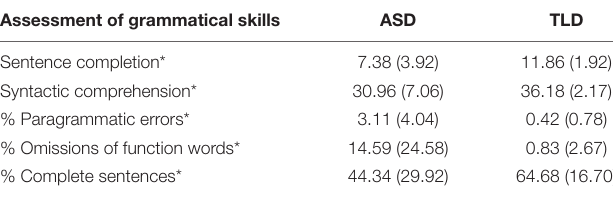
TABLE 3 | Results of the analysis of grammatical skills in the groups of participants with ASD and